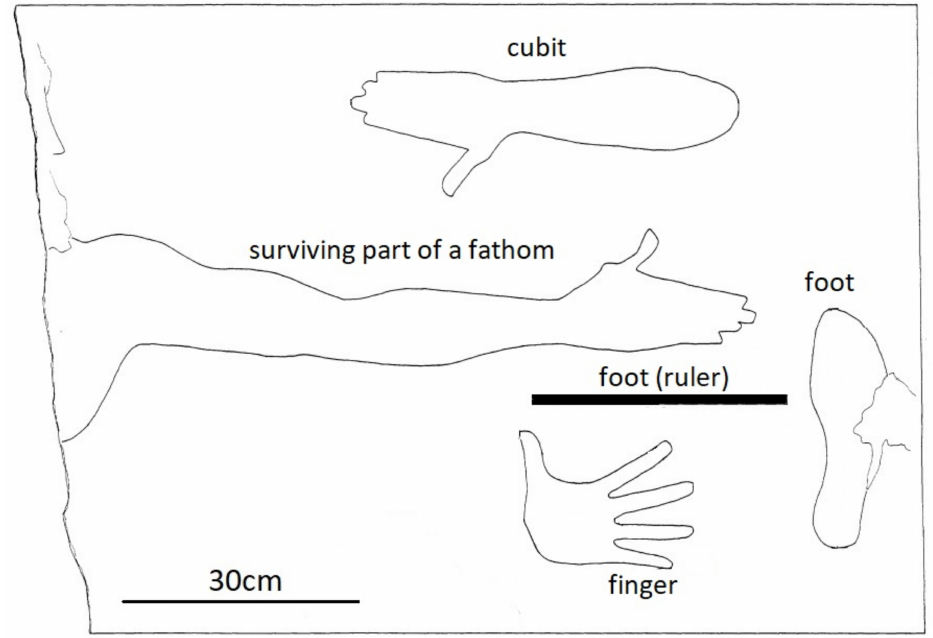
Figure 2. Schematic representation of the “Salamis metrological relief” showing metrological units. A cubit ( pechus ) 487 mm long, part of a fathom ( orgia ), a rule (highlighted) with length 322 or 327 mm, a foot with the length of 301 mm and a hand with fingers representing the subdivision of the foot. This is the only finding from the ancient Greek World showing a comparison of anthropomorphic length units with a ruler. Modified after